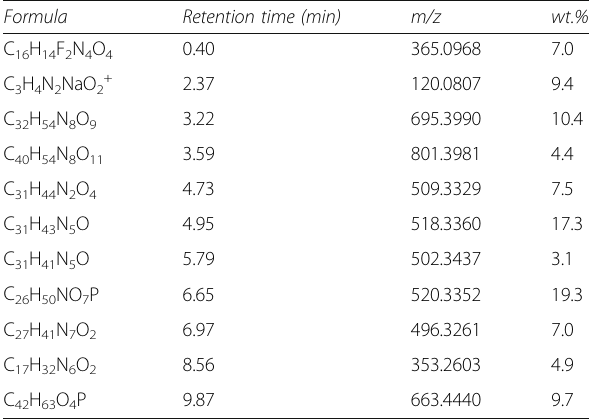
Table 3 Chemical constituents identified for APE using LC-MS analysis